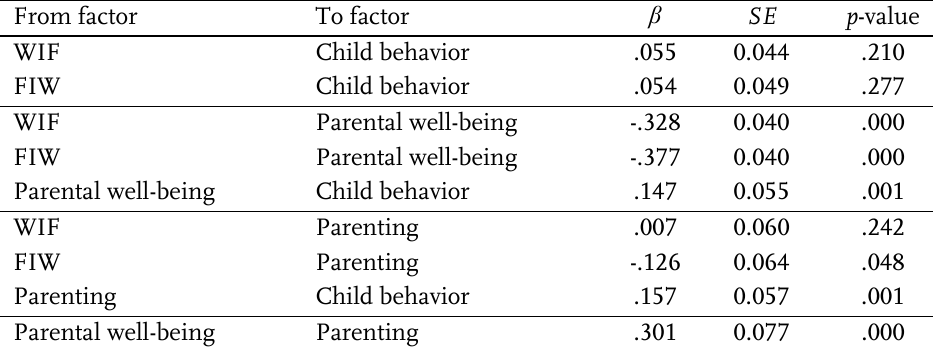
Table 2 : Structural model – Directional paths From factor To factor β SE p -value WIF Child behavior .055 FIW Child behavior .054 .277 WIF Parental well-being -.328 FIW Parental well-being -.377 Parental well-being Child behavior .147 WIF Parenting .007 FIW Parenting Parenting Child behavior .157 Parental well-being Parenting .301